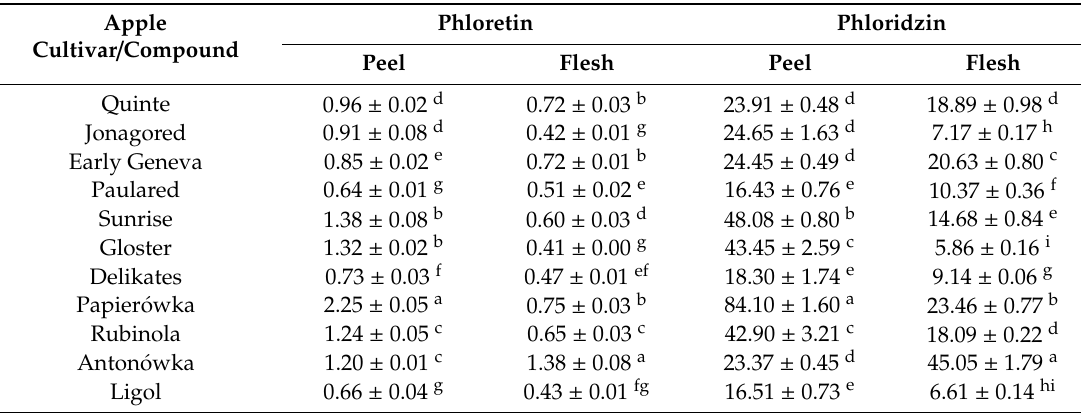
Table 1. Concentration of phloretin and phloridzin identified by the HPLC-DAD-MS/MS analysis in the peel and flesh of different apple cultivars.